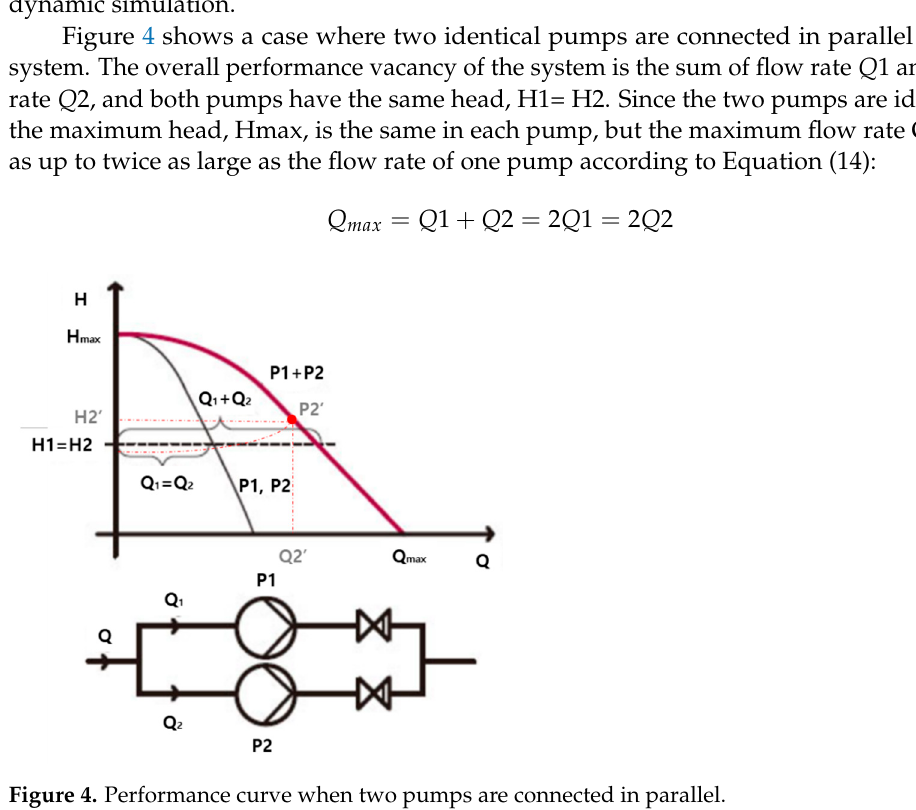
Figure 4. Performance curve when two pumps are connected in